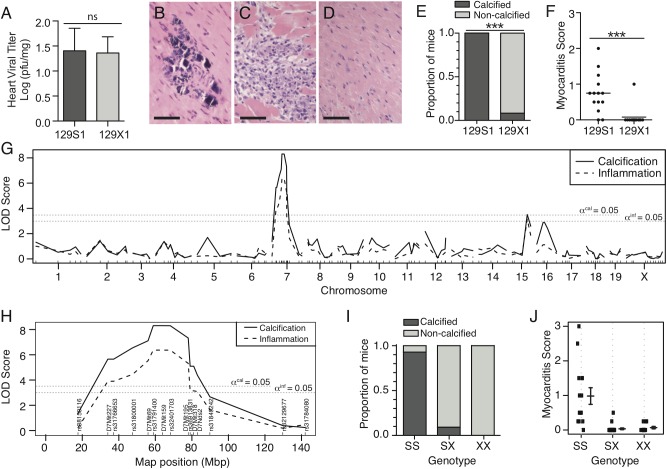
Differential susceptibility to viral myocarditis is controlled by a chr. 7 locus.Cardiac viral titer and histopathology were examined in 129S1 and 129X1 mice infected with 500pfu/g CVB3. Viral titer was equal between both strains (A). 129S1 mice developed calcified lesions (B, E) and increased inflammation (C, F) in response to CVB3 infection. 129X1 mice very rarely presented with either (D, E, F). Analysis of phenotypic segregation and linkage mapping in an (129S1 x 129X1) F2 population identified a common, highly significant locus for each phenotype (Calcification: LOD = 8.307, P<0.0001; Inflammation: LOD = 6.370, P<0.0001) (G). Peak linkage for both traits occurred on Chr. 7 between markers D7Mit69 (56.3 Mbp) and rs32401703 (68.2 Mbp) (H). Recessive inheritance of homozygous S1 alleles conferred susceptibility to both phenotypes (I,J). Statistical tests were chi-squared test and student’s t test for panels E and F respectively. *** P<0.001. Bar = 50m.